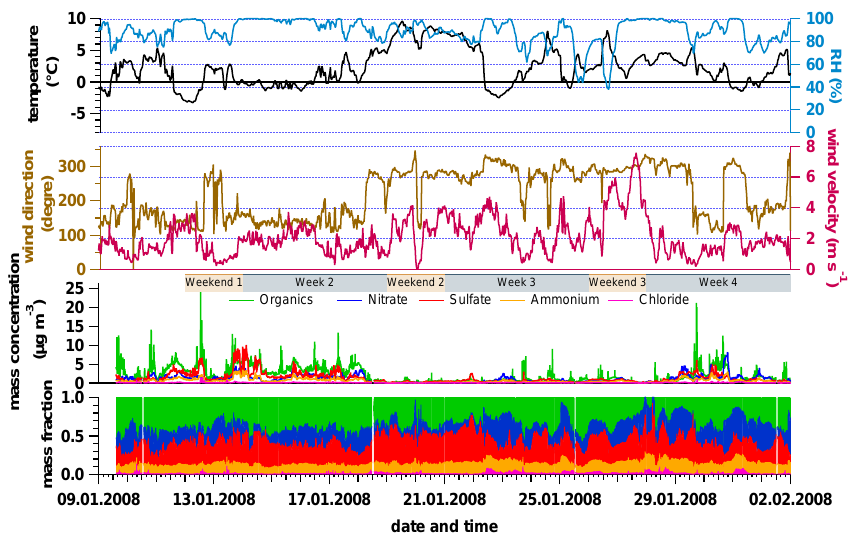
Fig. 1. Campaign overview including local meteorological variables (relative humidity (RH), temperature, wind direction and wind velocity according to a time resolution of 30 min), and time series (5 min time resolution) mass concentration and mass fraction of the main NR- PM 1 aerosol components during the AMS campaign. The number of week and weekend referred to the one used for the diurnal pattern